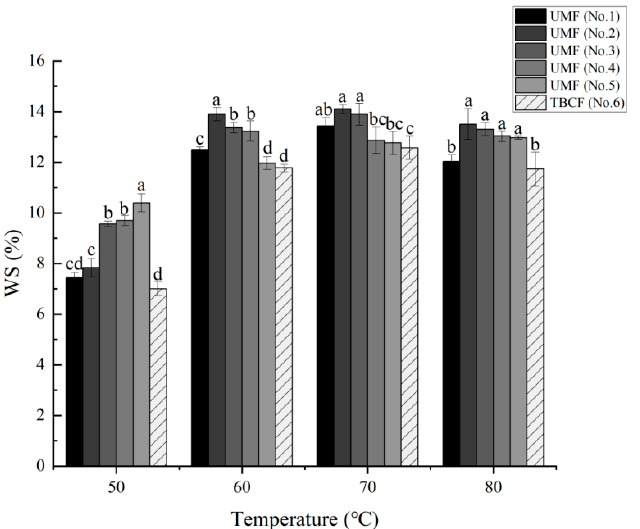
Figure 5. Effects of airflow ultrafine-grinding on the water solubility in Tartary buckwheat flour. The values represented by the different letters are significantly different at p < 0.05 compared with each other among the same temperature.